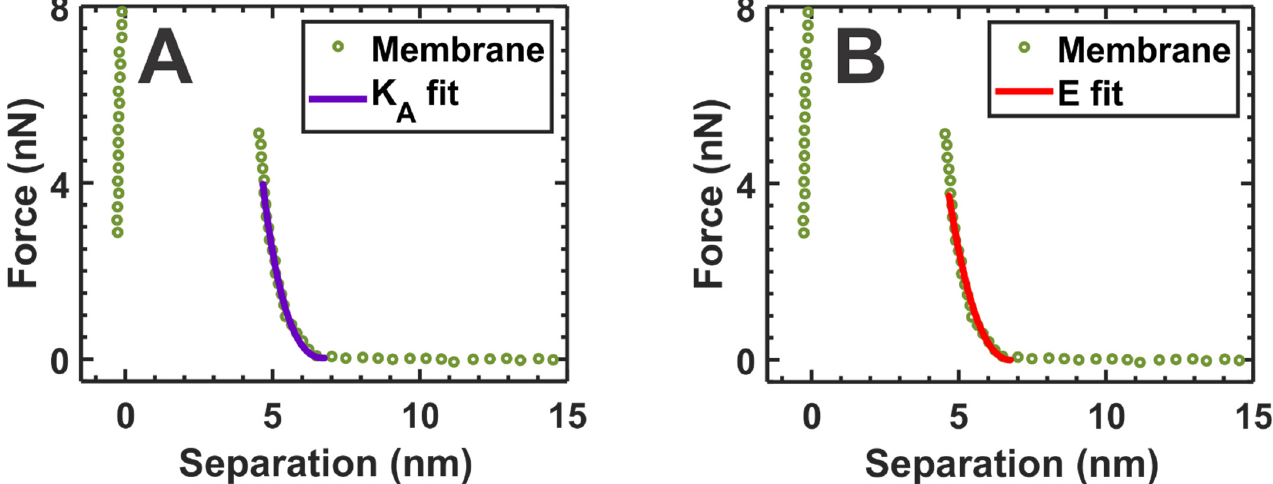
Figure 4. ( A ) Representative fit of Equation (1) with the force curve to calculate the membrane’s area compressibility modulus ( K A ), where K A is a measure of membrane elasticity [54]. ( B ) Representative fit of Equation (2) with the force curve to calculate the Young’s modulus ( E ), where E is a measure of membrane elasticity [64]. The representative force curve is taken from the membrane region indicated by the green arrowheads in Figure 3B.